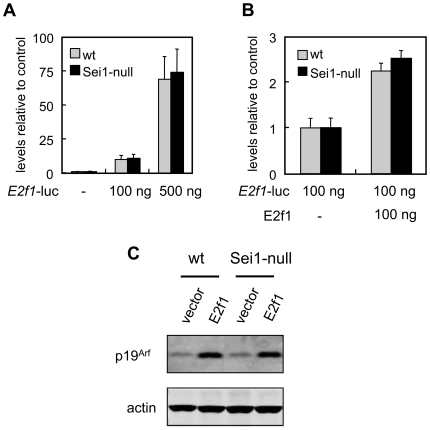
E2f1 activity in Sei1-null cells.
(A) Endogenous E2f1 activity was measured by transfecting at least three independent preparations of primary MEFs per genotype with different amounts of a plasmid carrying the luciferase reporter under the regulation of the E2f1-responsive E2f1 promoter. Luciferase activity was measured two days after the transfection. Values represent the average and s.d. (B) Ectopic E2f1 activity was measured as before after co-transfection with different amounts of a plasmid expressing E2f1. (C) Levels of protein p19Arf, a bona-fide E2f1 target, were assessed by immunoblotting of extracts from MEFs of the indicated genotypes transduced with E2f1. These results were confirmed in another independent assay. Actin was used as a loading control.